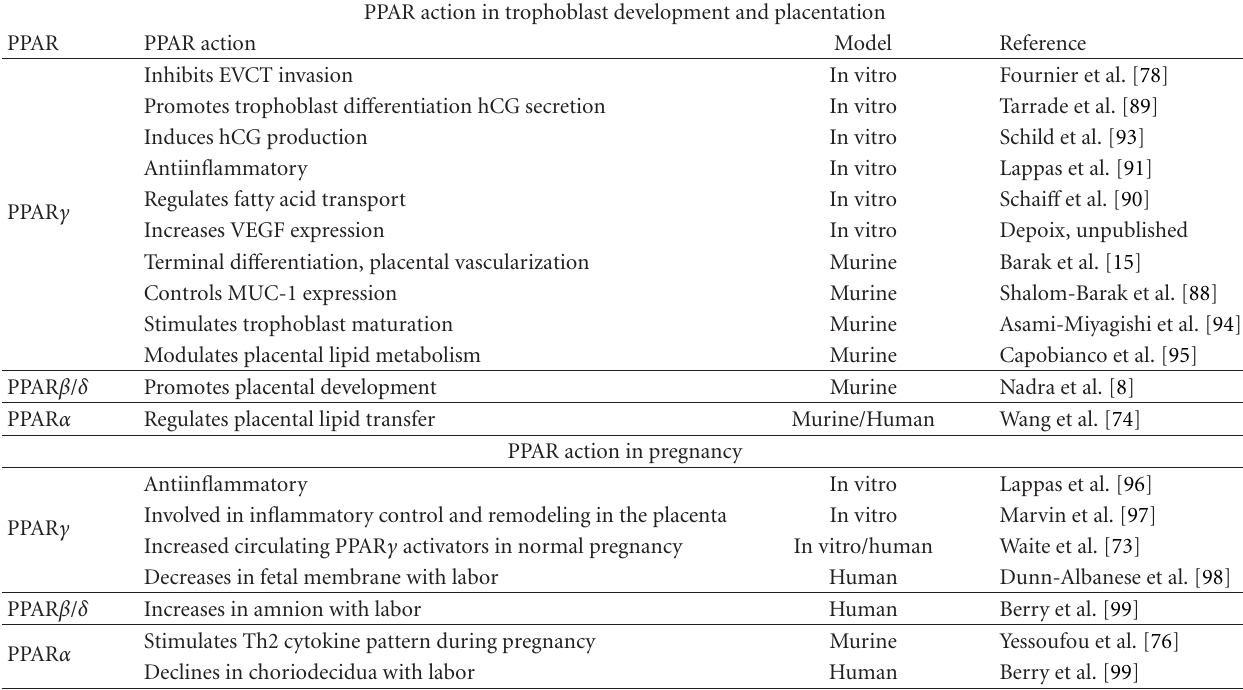
Table 4: PPAR action in trophoblast development and placental function (MUC-1: mucin-1; EVCT: extravillous cytotrophoblast; hCG: human chorionic gonadotropin; Th2 T-helper 2